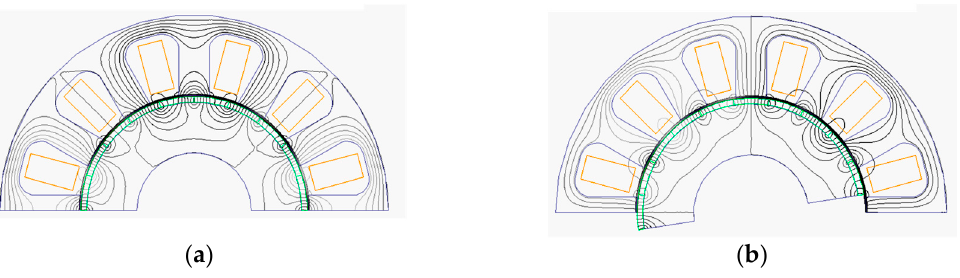
Figure 4. Flux lines of the vernier with rotor positions. ( a ) when θ m = 0°; ( b ) when θ m = 9°.